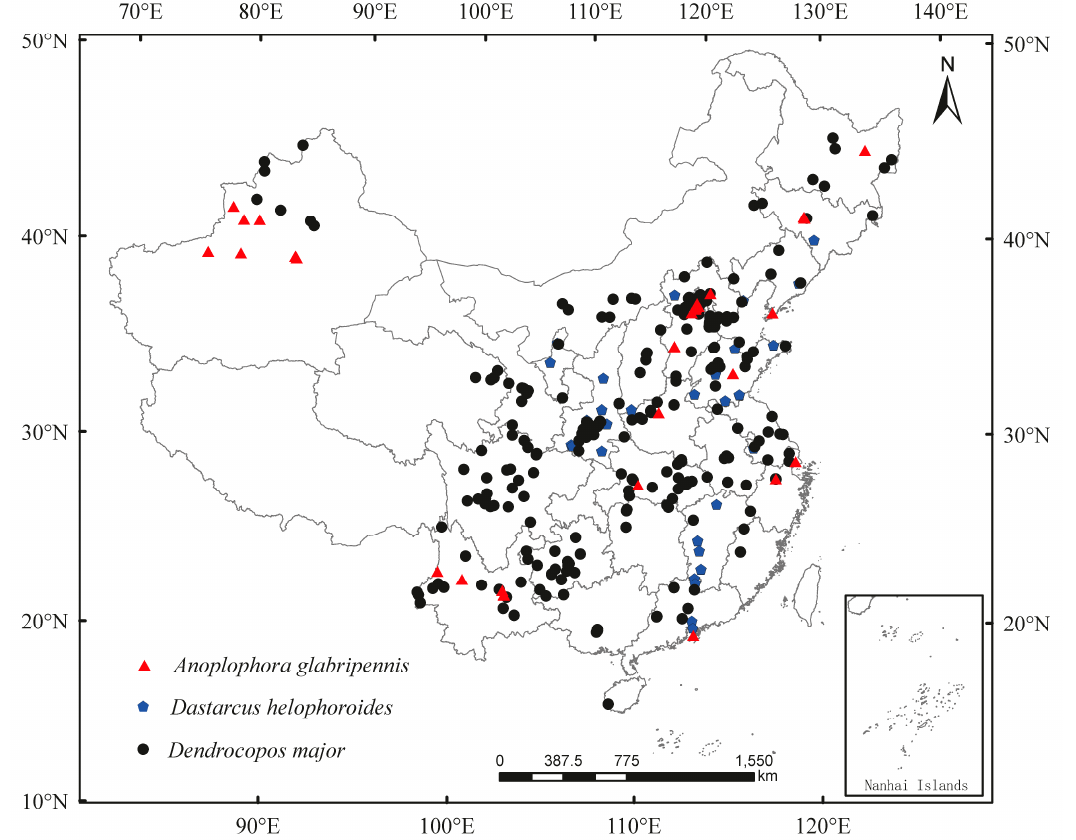
Figure 1. Known geographical distribution of Anoplophora glabripennis , Dastarcus helophoroides , and Dendrocopos major in